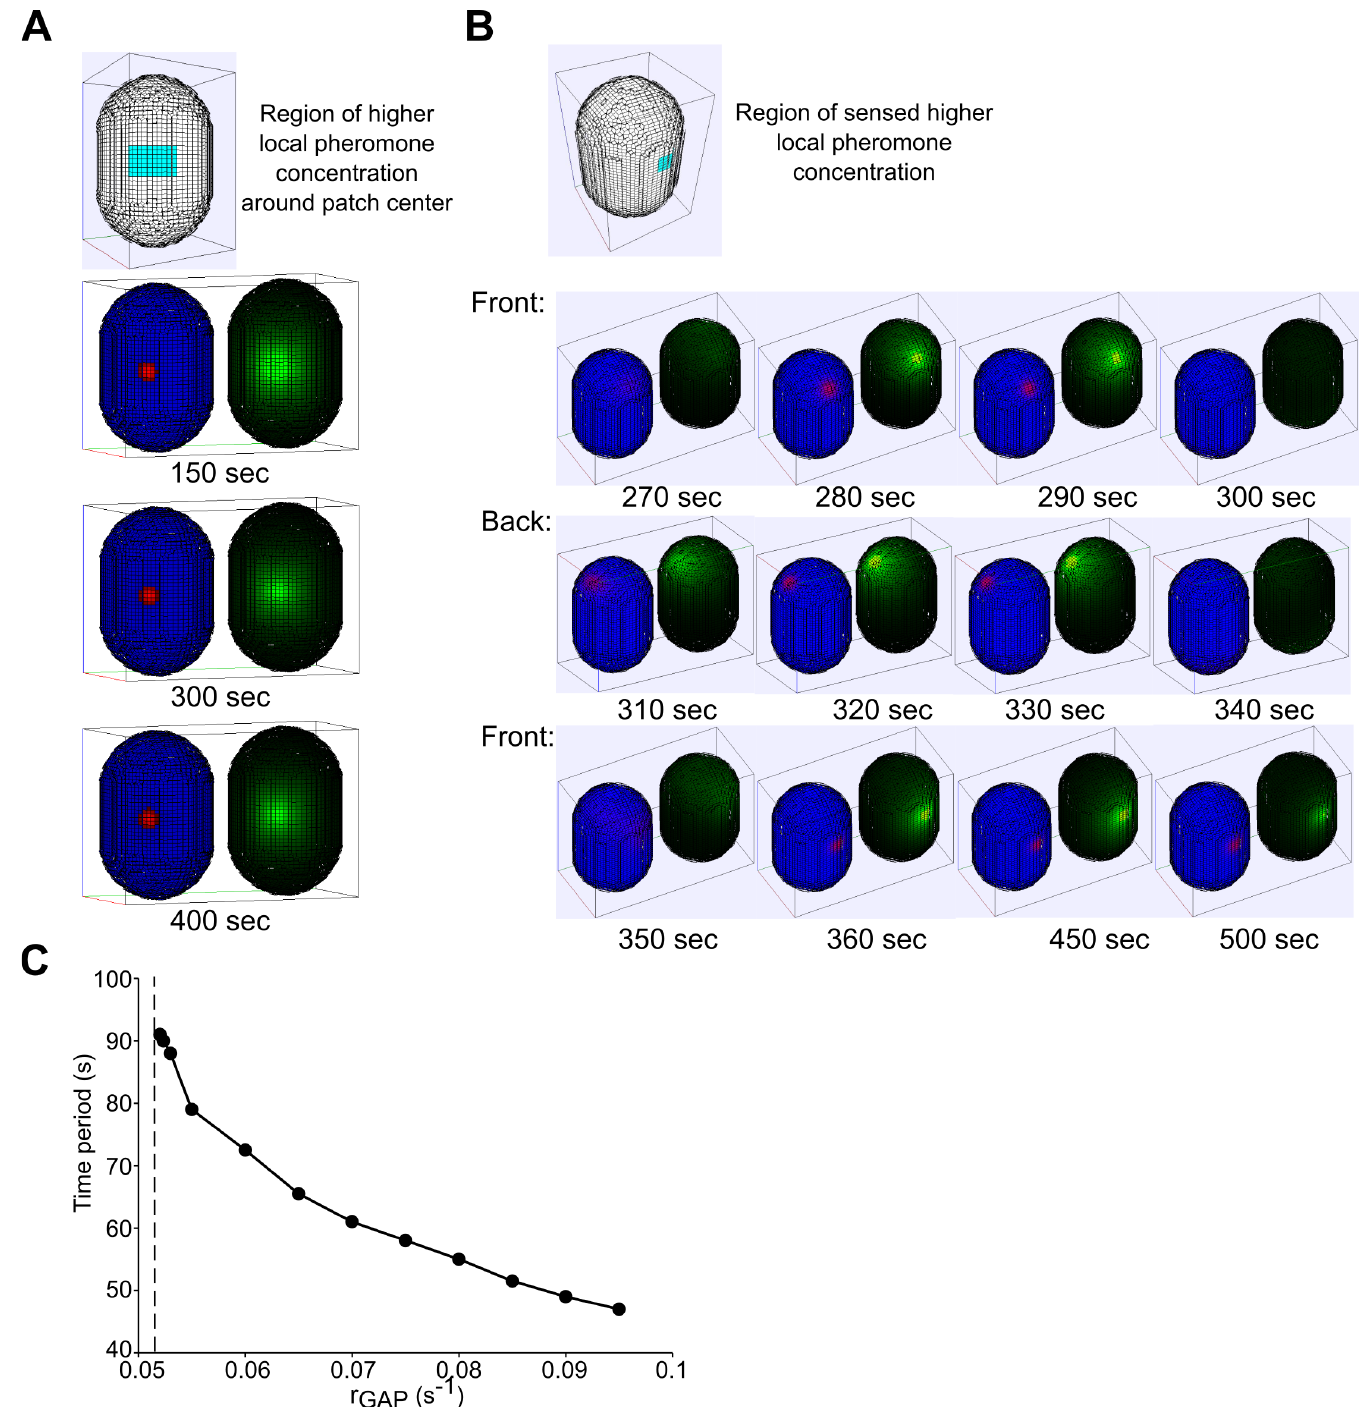
Fig 6. Patch stabilization through changes in model parameters. (A) Simulation of local increase in positive feedback over a region around the patch center (Ras1 activation rate constant k p increased by 1.25 times over cyan colored region without any change compared to Table 1 values in white region) results in stabilization of the 0 exploring patch. (B) Simulation of local increase in positive feedback at a specified fixed region on the membrane (Ras1 activation rate constant k p increased by 1.2 times 0 over cyan colored region without any change compared to Table 1 values in white region). Snapshots show patch exploration and stabilization at the site of local positive feedback increase. Note that middle row shows back-side upside-down snapshots. (C) Time period of exploring patch appearance and disappearance increases with decreasing detachment rate constant of Gap1, r . It converges to 91 seconds before further decrease of r below dashed line results in formation of a stable patch. GAP GAP